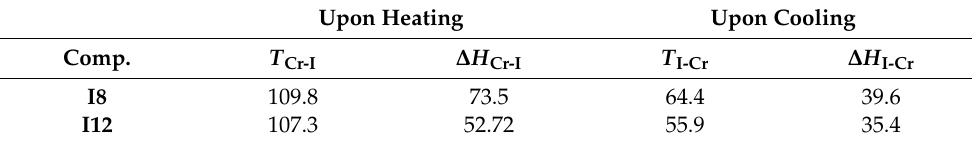
Cr-I: transition from solid–isotropic liquid phase; I-Cr: transition from isotropic liquid–solid